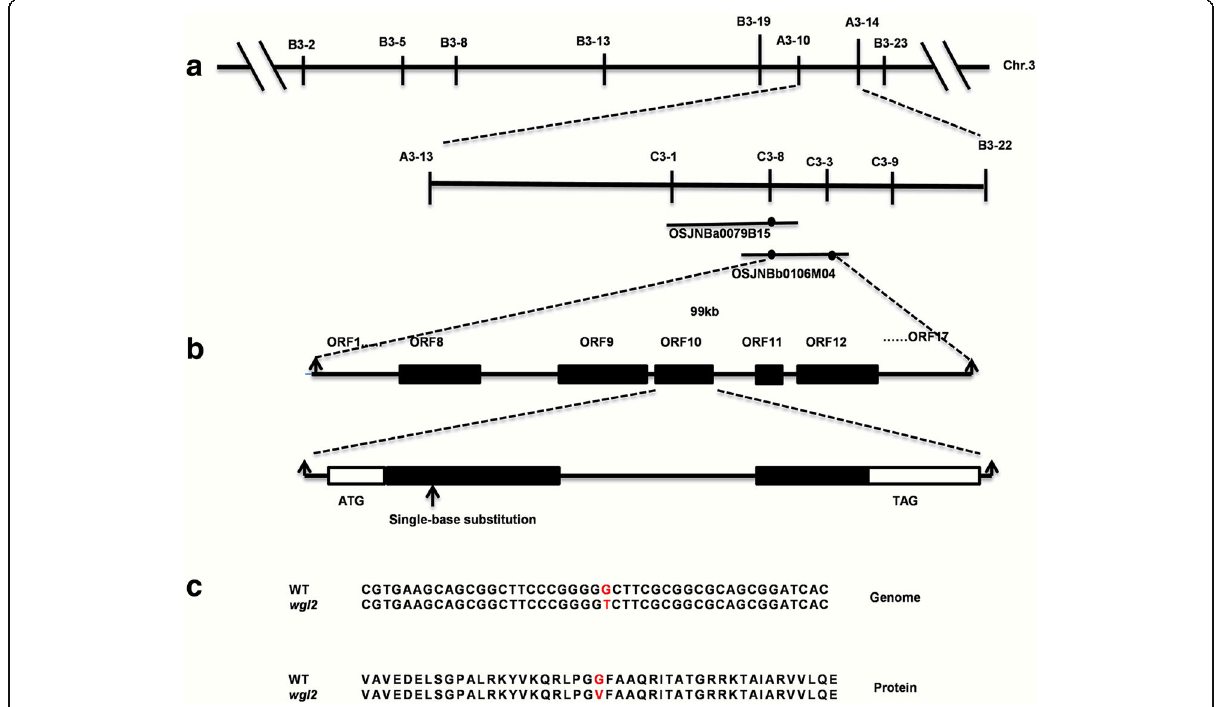
Fig. 3 Map-based cloning and identification of the mutation site in wgl2. a The WGL2 locus was initially mapped to Chromosome 3 (Chr. 3). b The WGL2 locus was fine-mapped to a physical interval of 99 kb using the indicated markers. c Mutation site in WGL2 at the genome and protein